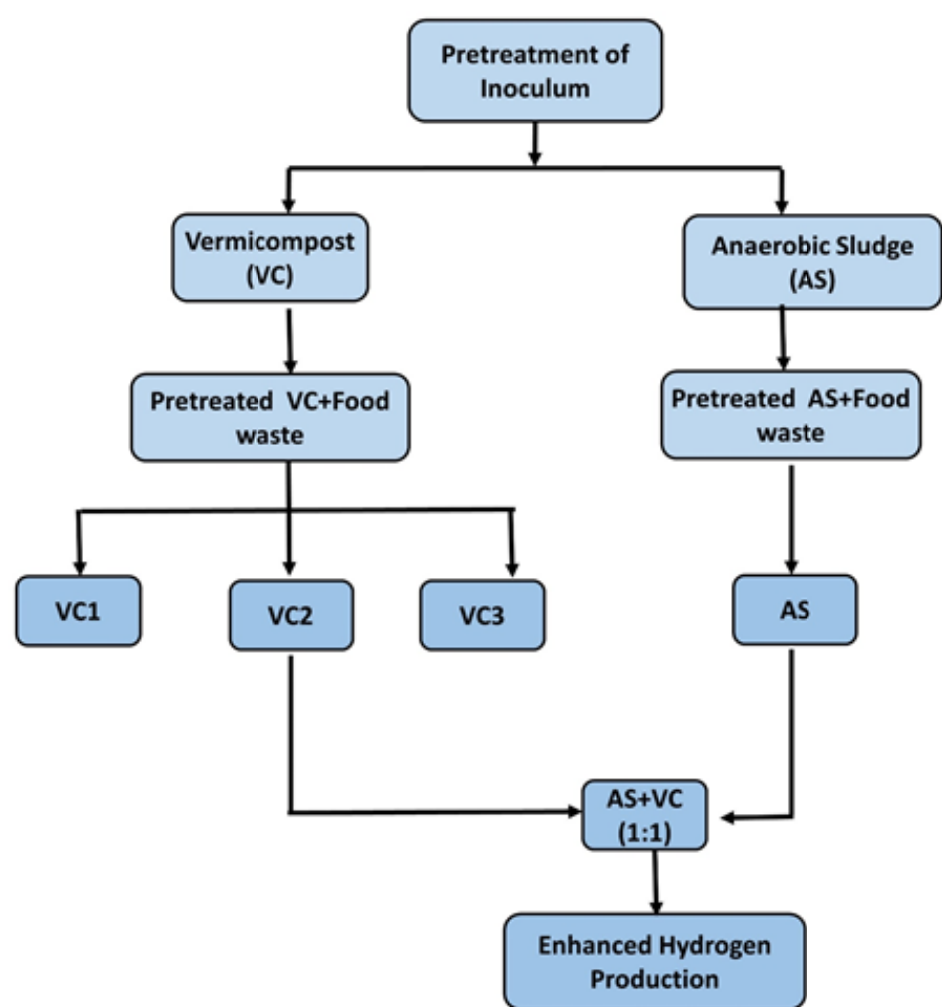
Figure 3. Biohydrogen production from food waste using pretreated anaerobic sludge (AS-20 mg/L), vermicompost as inoculum (VC1-10 mg/L, VC2-20 mg/L, VC3-30 mg/L) and (AS+VC 1:1).